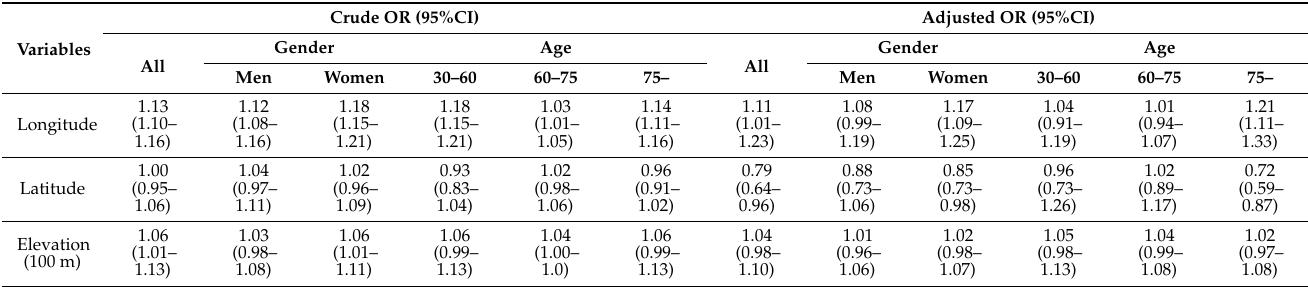
Table 2. The associations between diabetes mortality with longitude, latitude and elevation (100 m) in 31 surveillance points, crude and adjusted odds ratio (OR) and 95% confidence interval (CI) in the negative binomial model (longitude, latitude and elevation (100 m)).